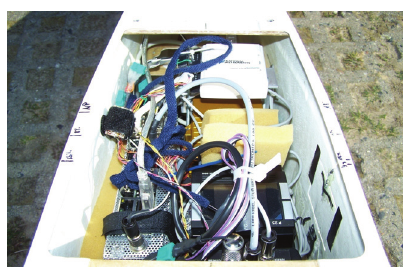
Figure 3. The SMAP Camera